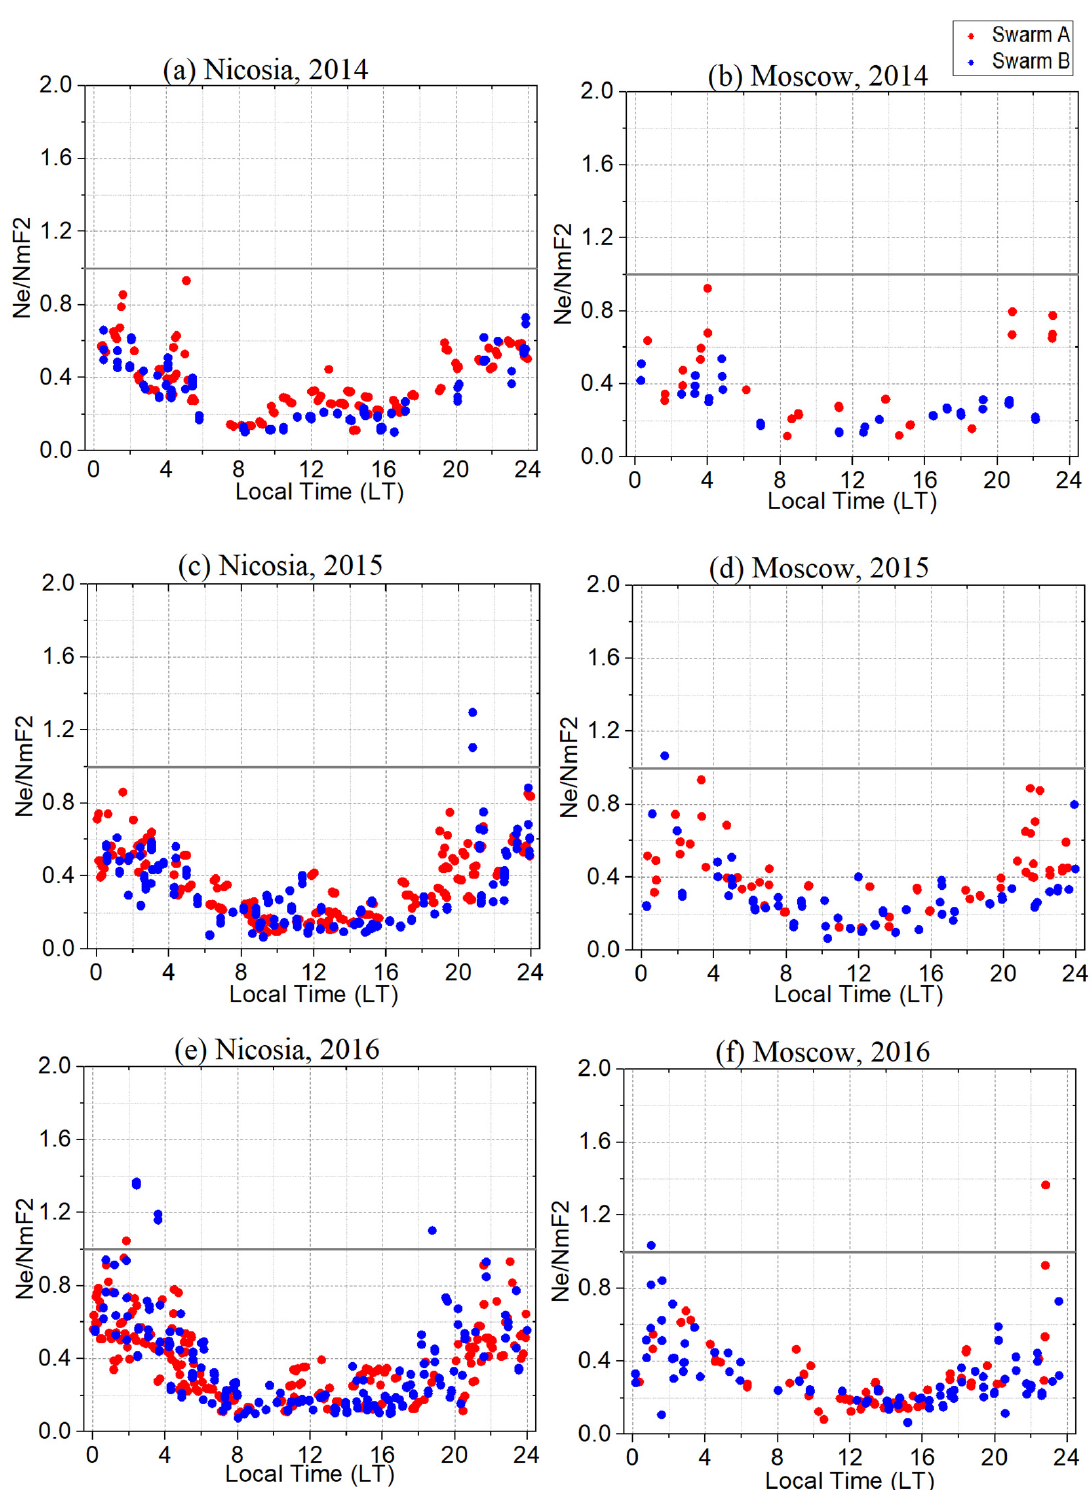
Figure 2. ( a – f ). Ne/NmF2 from Swarm A and B over Moscow and Nicosia for high-to-moderate solar activity during 2014 to 2016.